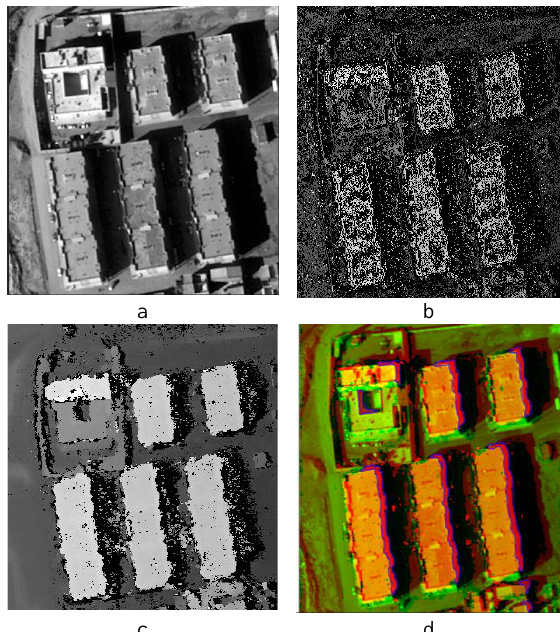
Figure 1. The shadow effect on cost aggregation step (SGM algorithm). a) Panchromatic image; b) computed disparity map without cost aggregation; c) computed disparity map after cost aggregation; d) overlaid disparity map and panchromatic image (the extended roof).